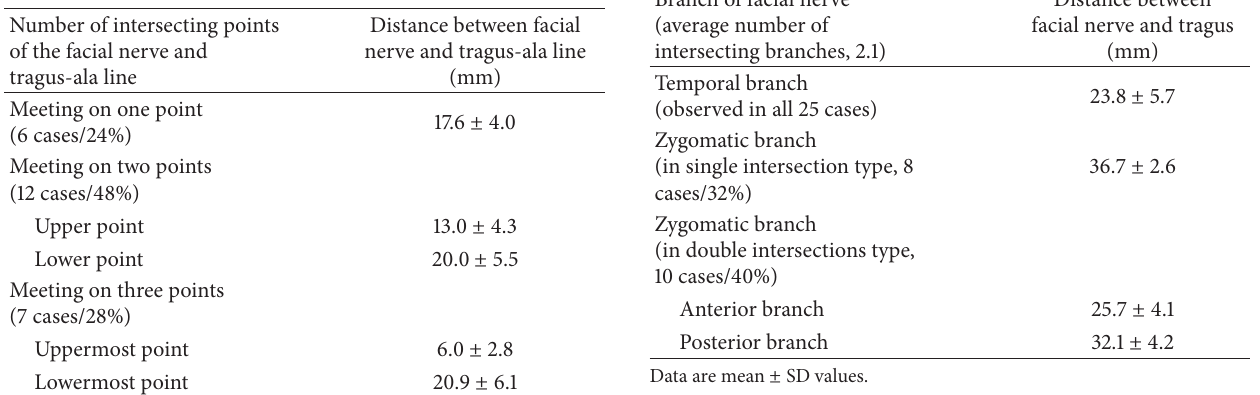
Figure 2: Three types of branching pattern of facial nerve at the condylar area. (a) Type I (single trunk), (b) Type II (double trunks), and (c) Type III (nervous loop or plexiform). Branches of facial nerve: Tbr: temporal branch; Zbr: zygomatic branch; Bbr: buccal branch; Mbr: marginal mandibular branch; Sb: superior trunk; Ib: inferior trunk. Table 2: Location of the facial nerve on the tragus-ala Table 1: Location of the facial nerve with 2 cm advanced to the tragus.